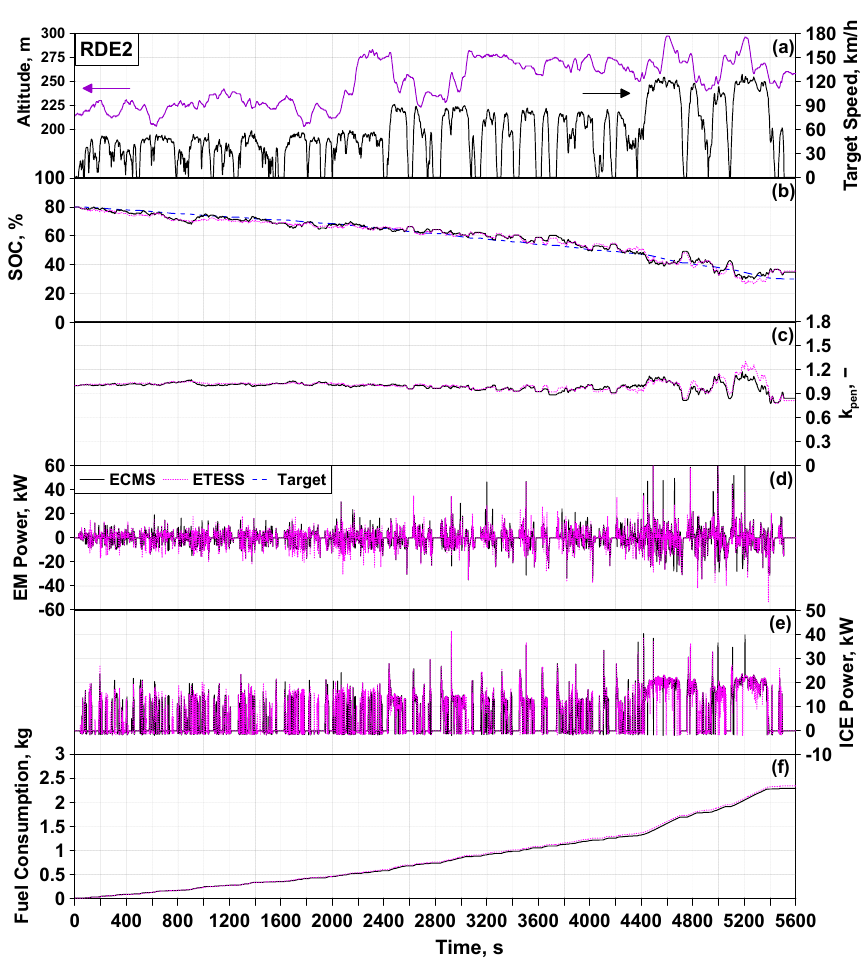
Figure 15. RDE2, ( a ) target speed. ETESS/ECMS comparisons of battery SoC ( b ), k pen ( c ), EM power ( d ), ICE power ( e ), and cumulated consumed fuel ( f ).